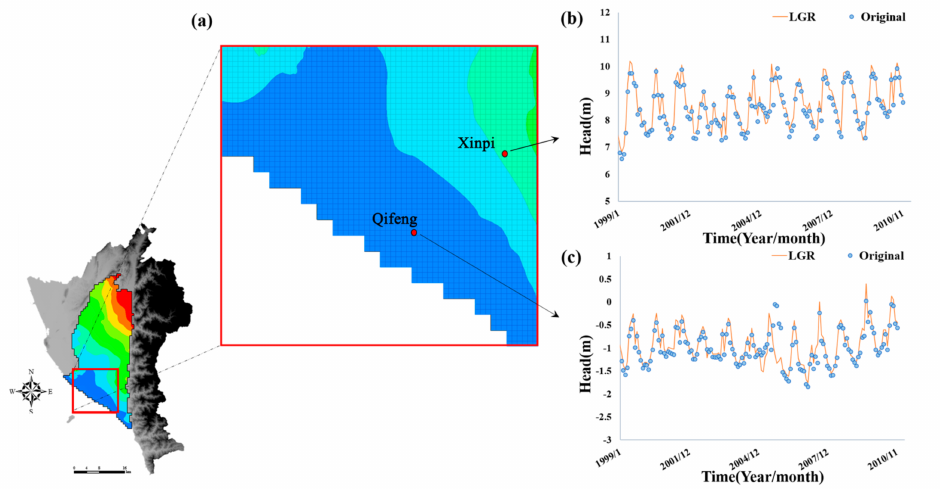
Figure 6. The refined groundwater flow model of Pingtung Plain coastal area: ( a ) the model grids; ( b ) simulated groundwater levels at Xinpi; and ( c ) simulated groundwater levels at